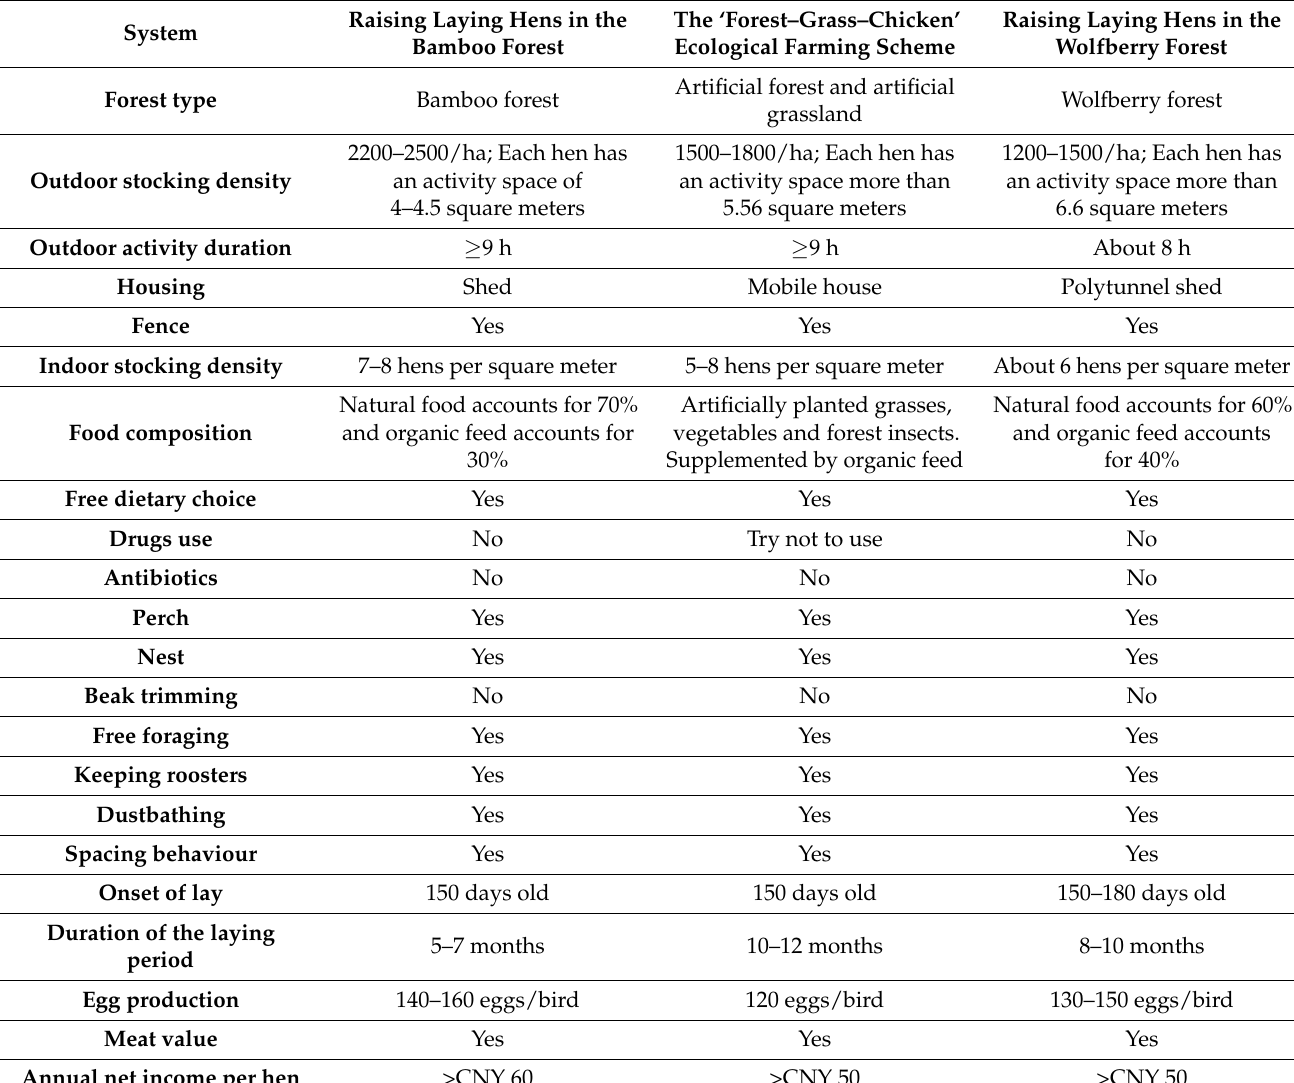
Table 1. Characteristics of three understory laying hen management